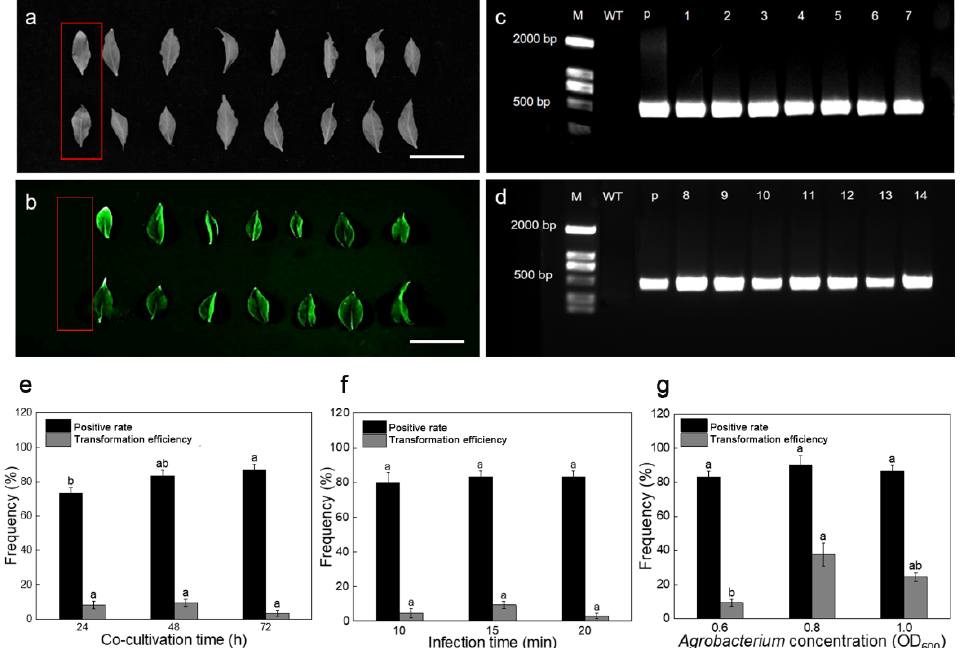
Figure 2. Evaluation of three factors affecting transformation efficiency. ( a , b ) Phenotype analysis of wild-type (red boxes) and transgenic plantlets under white light ( a ) and fluorescence ( b ). Scale bars = 2 cm. ( c , d ) PCR detection of the reporter gene eGFP in transgenic plantlets, with pBI121-GFP vector as a positive control (P) and wild-type plants as a negative control (WT). ( e ) Co-cultivation time, ( f ) Infection time, and ( g ) Agrobacterium concentration were found to differently affect the positive rate and transformation frequency of calli. Different lowercase letters indicate significant differences at p < 0.05.